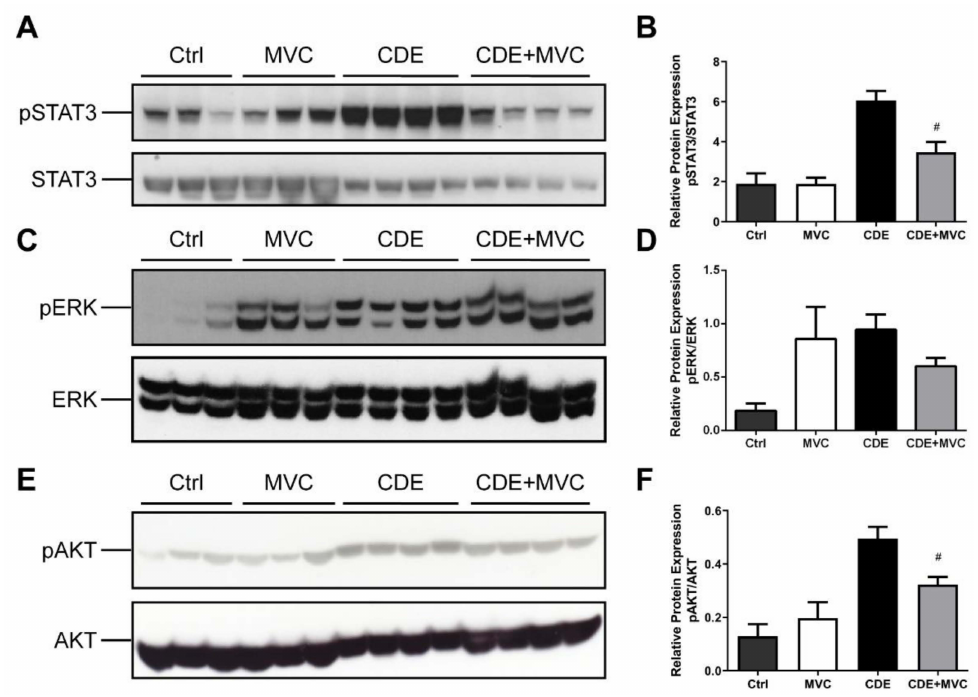
Figure 4. pSTAT3 and pAKT expression is attenuated by MVC in CDE liver. ( A , C , E ) protein lysates from livers of mice fed Ctrl, CDE, MVC or CDE+MVC diets for 16 weeks were immunoblotted and labelled for phosphorylated ( A ) STAT3, ( C ) pERK, ( E ) pAKT and their loading controls; total STAT3, ERK and AKT, respectively. ( B , D , F ) the abundance of each phosphorylated protein relative to its control was calculated through densitometry performed on the blot images. Bars represent means + SEM for n = 3 mice in the Ctrl and MVC groups and n = 4 in the CDE and CDE+MVC groups. # p < 0.05 compared to CDE